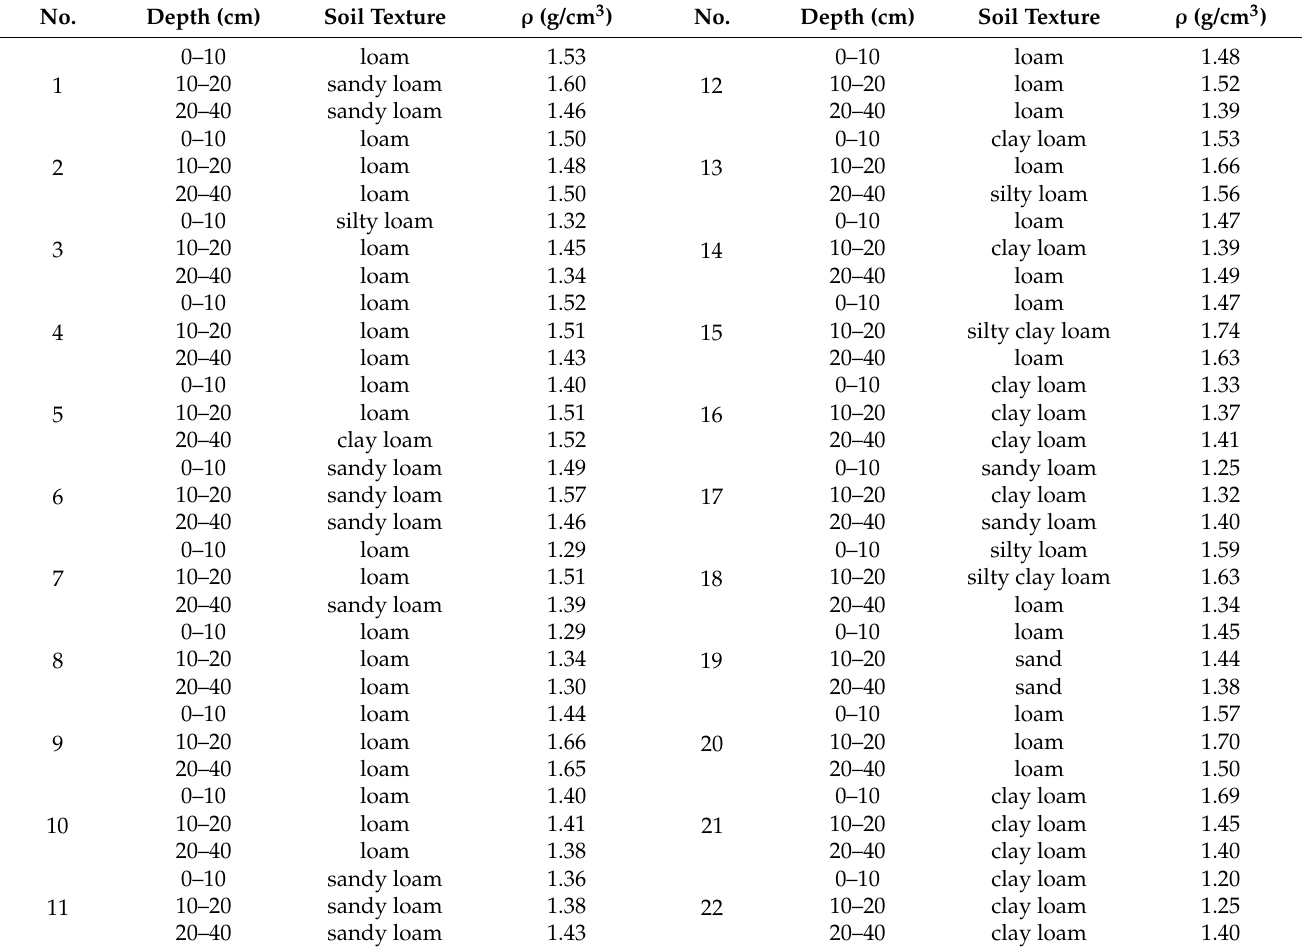
Table 1. The soil texture and dry bulk density ( ρ ) of the three soil layers at the 22 soil sampling